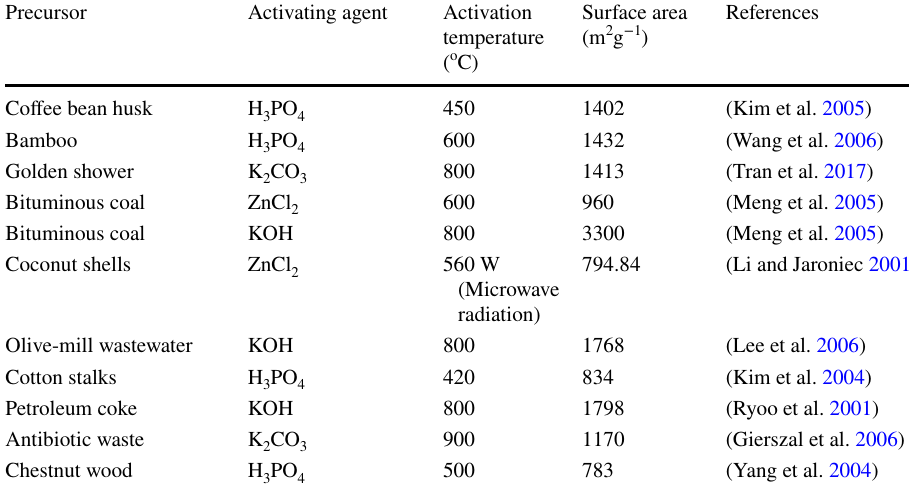
Table 1 Activated carbon produced by chemical activation